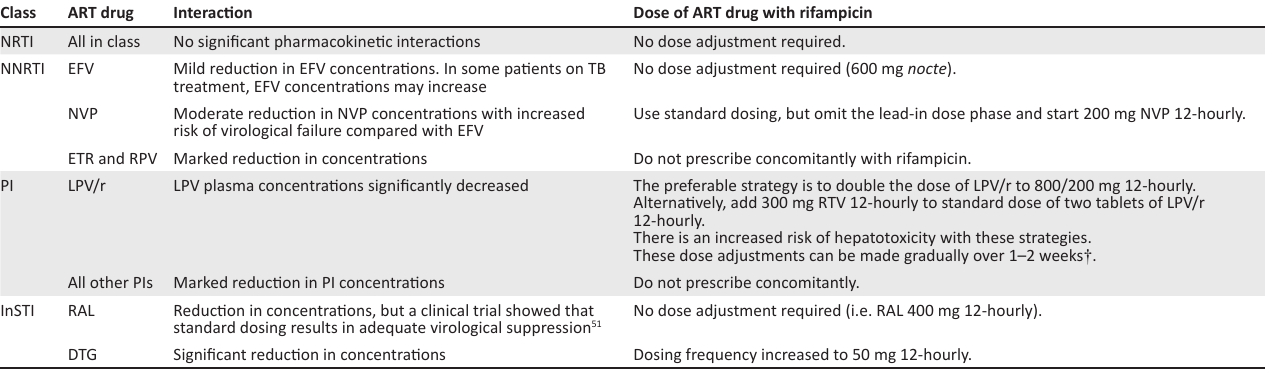
TABLE 8: Antiretroviral therapy interactions with rifampicin and recommendations for co-administration. Class ART drug